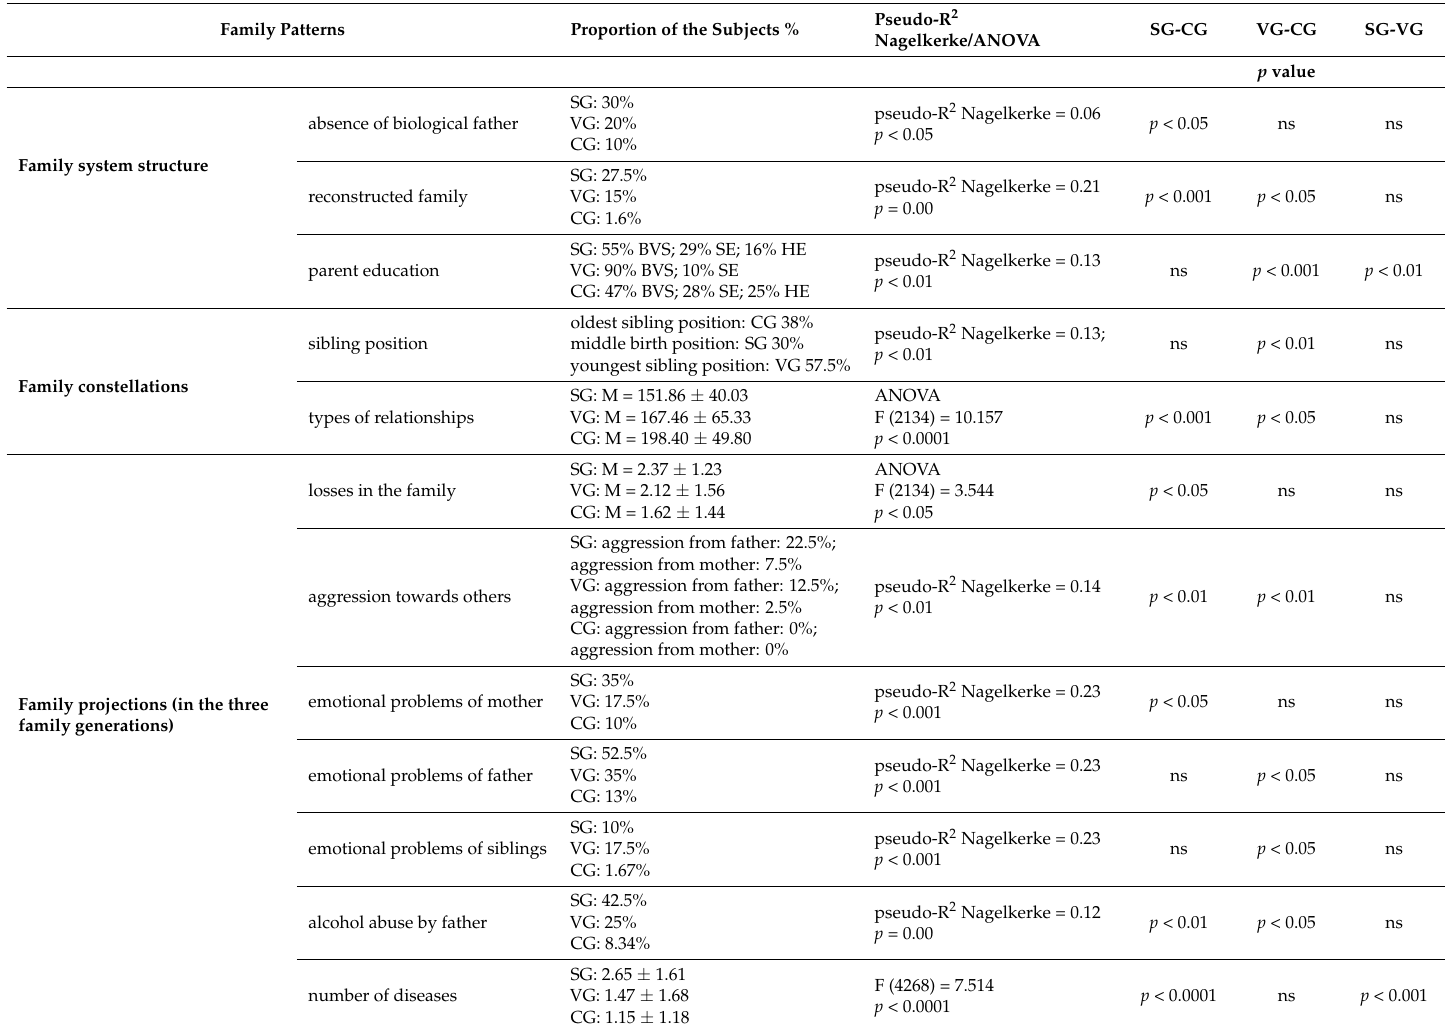
Table 1. Summary of the Patterns of Family Structure, Family Relationships and Family